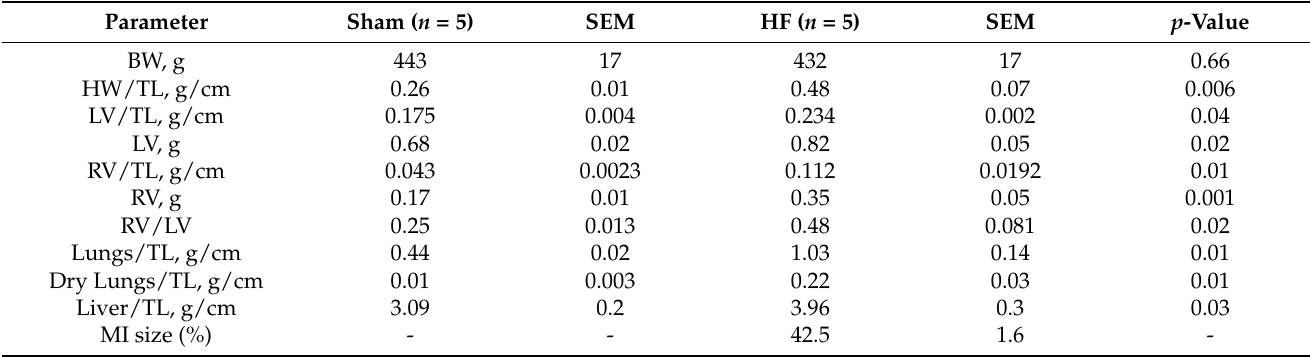
Table 1. Morphological